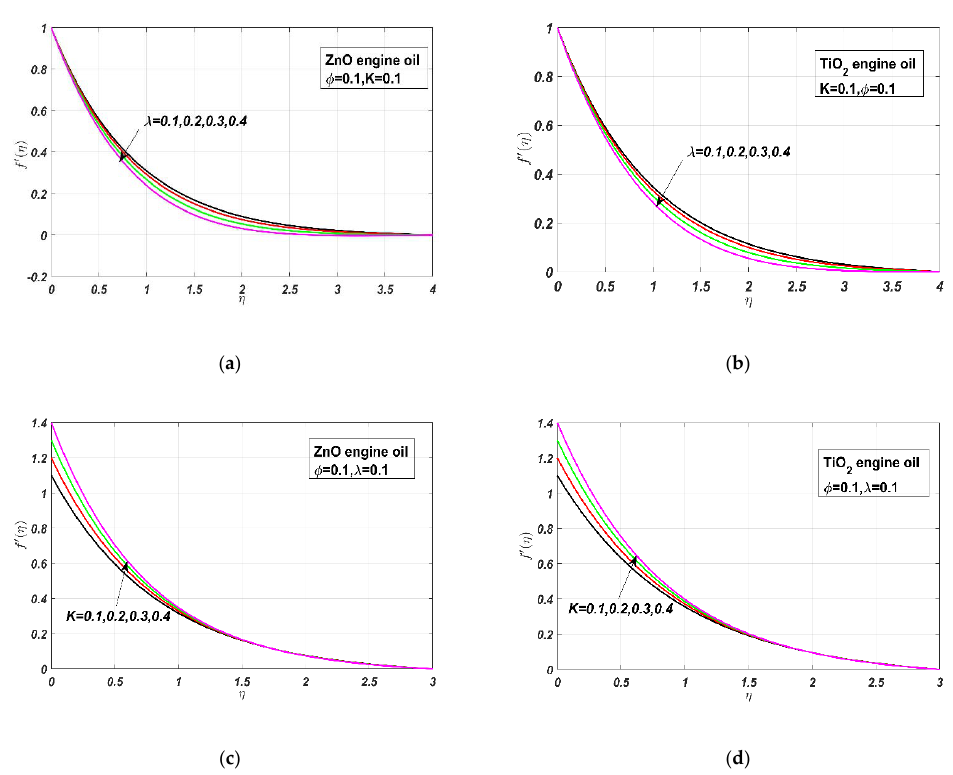
Figure 2. The impact of rotation parameter λ ( a , b ) and slip parameter K ( c , d ) on the velocity profile f (cid:48) ( η ) for ZnO and TiO 2 engine oil nanofluids.